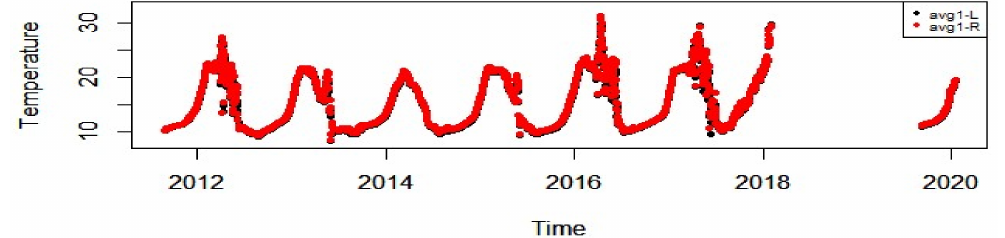
Figure 6. Avg1-R against avg1-L (Temperature in ◦